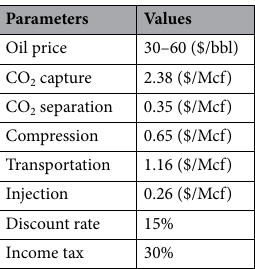
Table 4. The fiscal and economic parameter for CO 2 injection project.